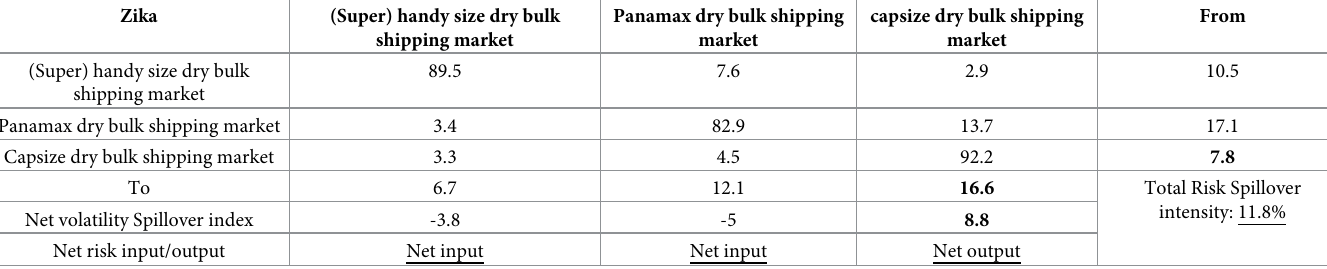
Table 12. Risk volatility spillover table of the dry bulk shipping market during the study period of the Zika epidemic. Zika (Super) handy size dry bulk shipping market